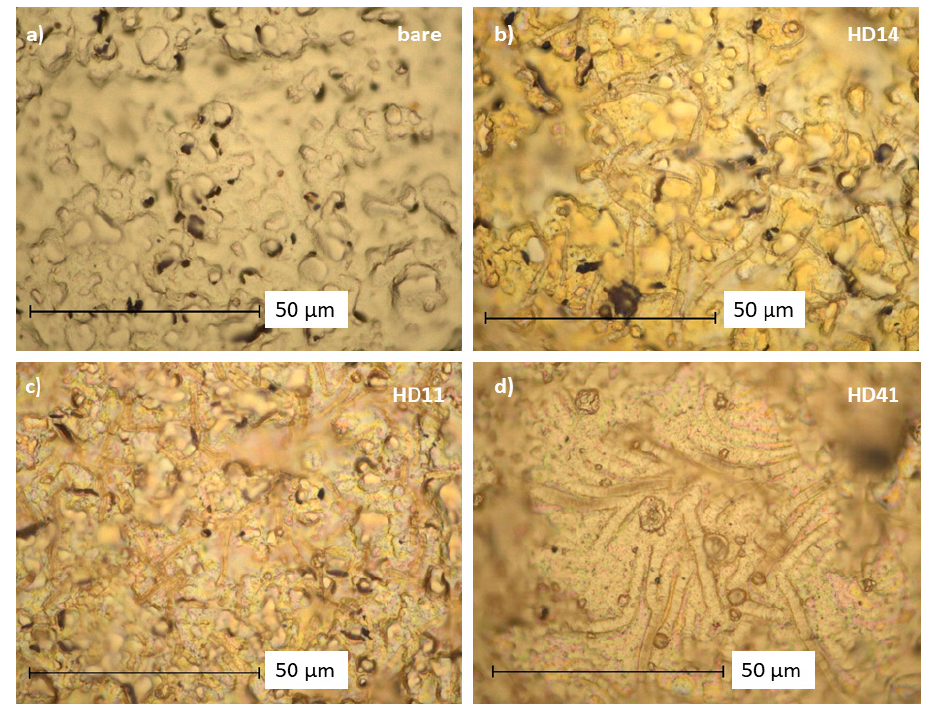
Figure 3. Optical microscope images (1500× magnification) of ( a ): the unmodiefied goldelectrode